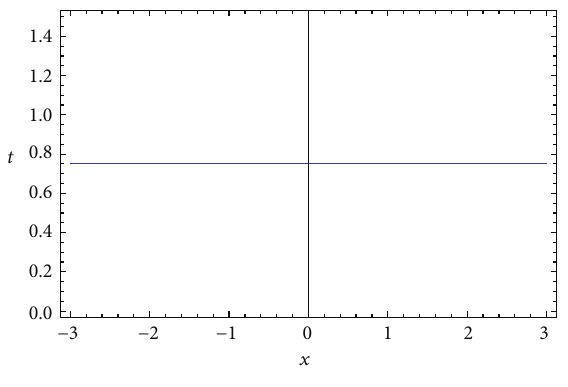
Figure 12: 2D, OHAM solution of 𝜂(𝑥, 𝑡) at 𝑡 = 0.1 .